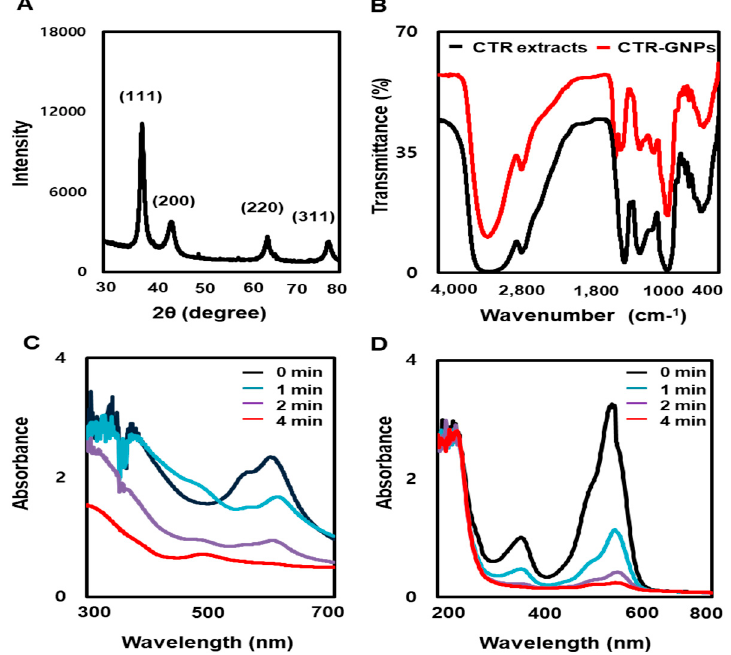
Figure 2. Physicochemical characterization of CTR-GNPs. ( A ) X-ray dispersion (XRD) pattern and ( B ) Fourier-transform infrared spectroscopy (FT-IR) spectra of CTR-GNPs, and UV-visible spectrum of ( C ) methylene blue and ( D ) Rhodamine B after the addition of CTR-GNPs.